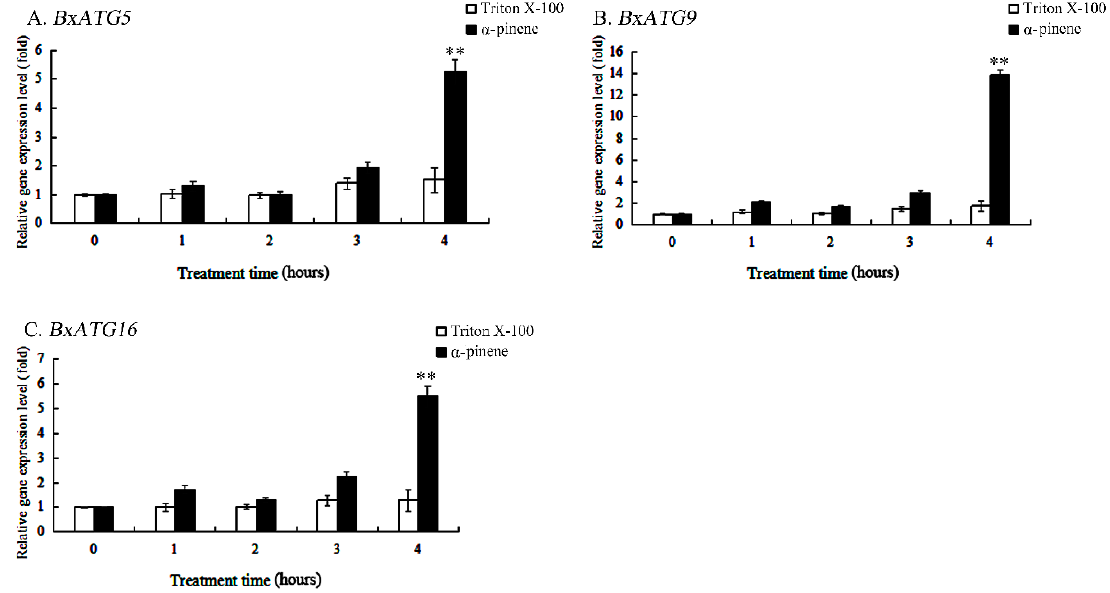
Figure 3. Relative expression levels of the autophagy genes BxATG5 , BxATG9 , and BxATG16 in PWN under α -pinene stress. Triton X-100 was used as the control. ( A ) BxATG5 . ( B ) BxATG9 . ( C ) BxATG16 . Data are presented as the mean ± SD. ** p < 0.01.